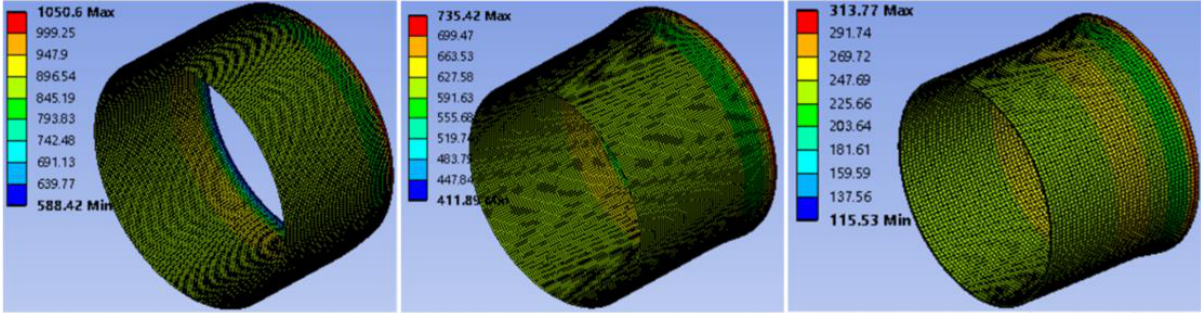
Figure 5. Damage nephogram of CFRP cylinder under different axial load conditions.